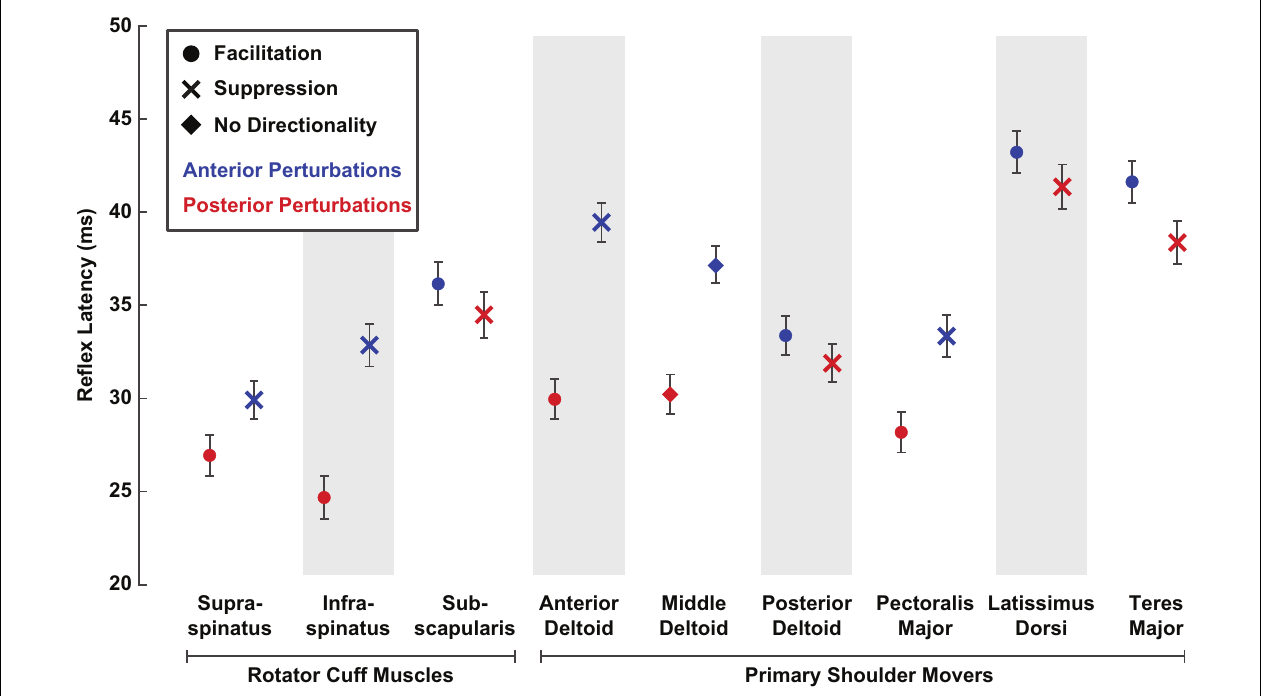
FIGURE 8 | Average latencies of stretch-evoked reflexes responding to translational perturbations of the glenohumeral joint. Reflex latencies were estimated as the time after perturbation onset when the average rectified EMG diverged positively or negatively from background activity by at least two standard deviations. Latencies were estimated separately for each perturbation direction. Only latency data from active trials (5% or 10% MVC) that elicited a reflex exceeding the threshold were included. Error bars represent the standard errors of the reflex